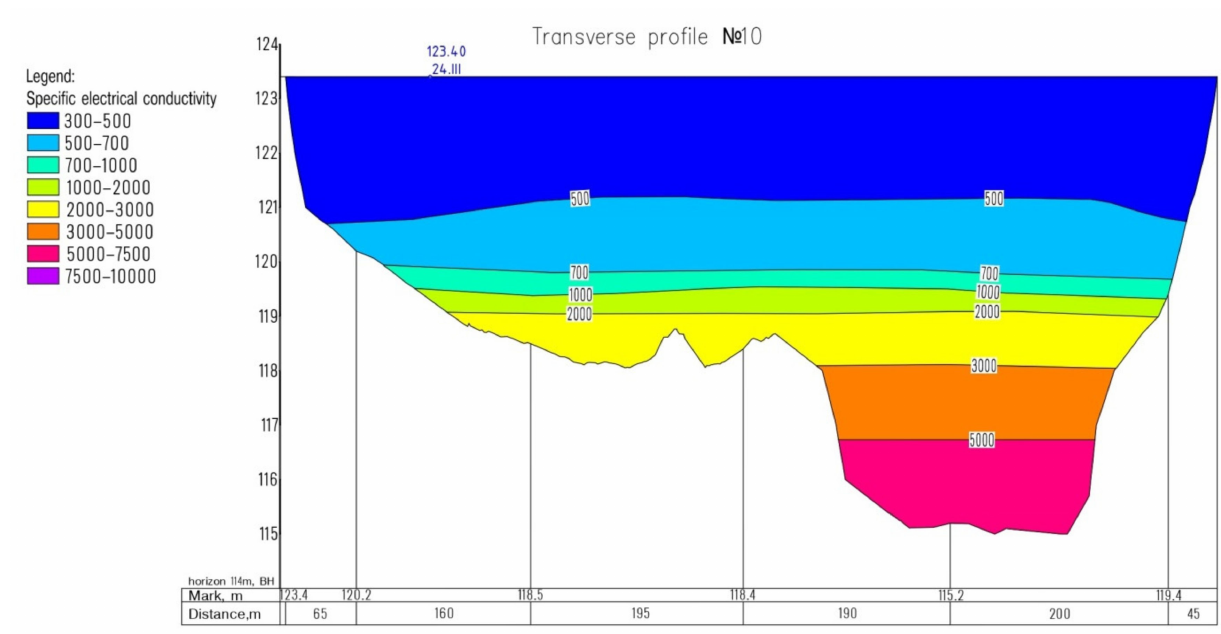
Figure 5. Transverse profile of the distribution of the obtained values of specific electrical conductivity ( µ S/cm) in the water area of the Verkhne-Zyryansk reservoir during the winter low-water along section No. 10 (distance in m from the right